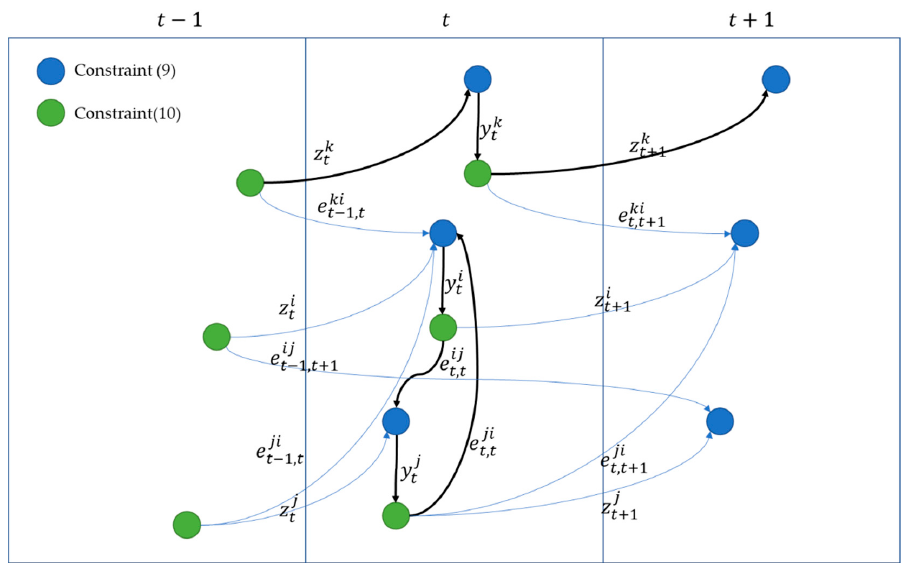
Figure 1. Illustration of a network with setup related constrains and variables and a subtour. (10) Green nodes denote constraints and (9) blue nodes denote constraints. Variables corresponding to thick arcs have values of one, and the others have values of zero. Circular setup change between ( i , j ) generates a subtour.